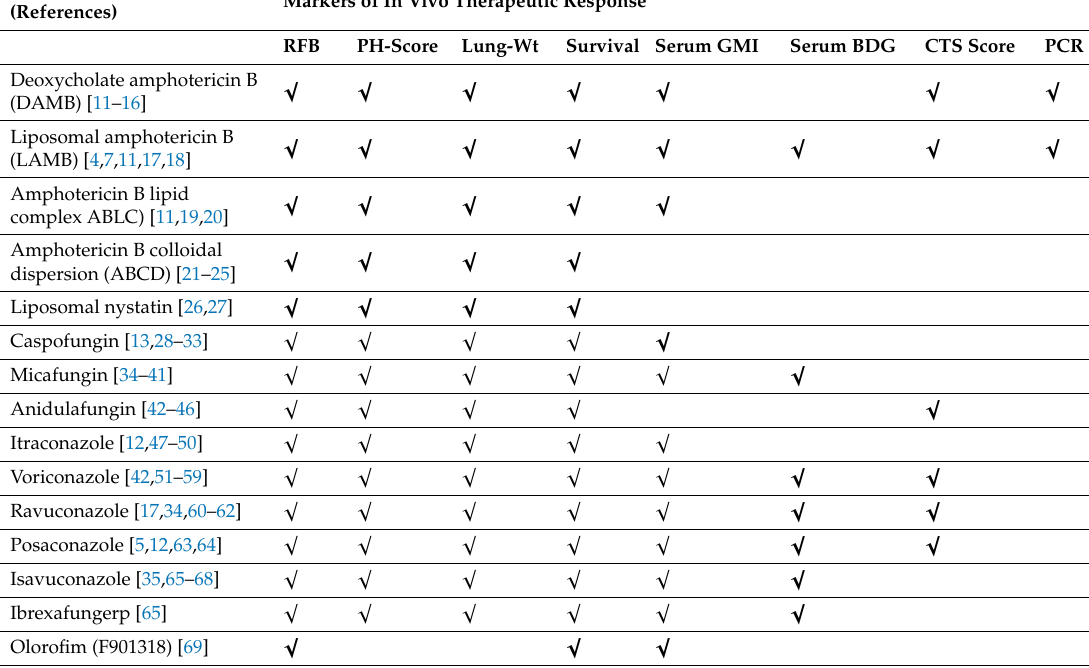
Table 1. Antifungal agents, preclinical studies in the persistently neutropenic and non-neutropenic rabbit model systems of invasive pulmonary Aspergillosis , and related clinical